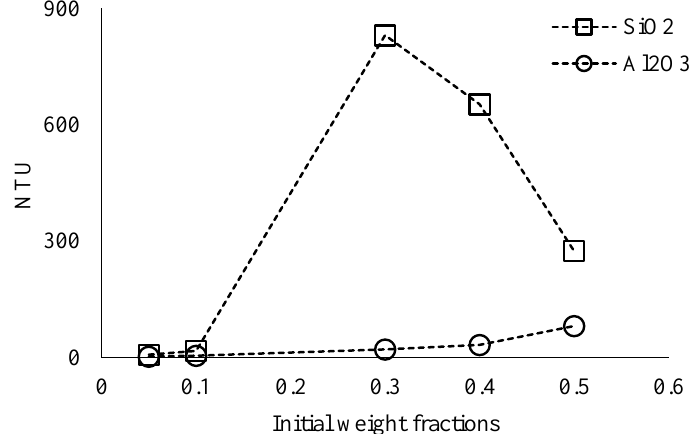
Figure 2—Residual turbidity in National Turbidity Unit NTU of Al